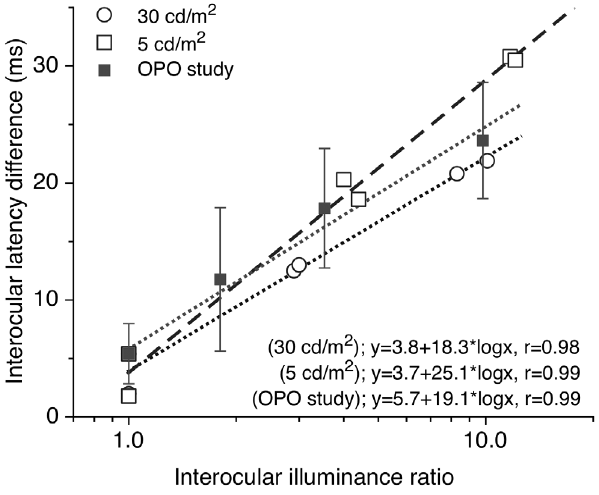
Figure 5. Interocular differences in VEP latency as a function of the interocular ratio of retinal illuminance. VEP latency is averaged for recordings between Day 0 and Day 7 and is plotted for two photopic luminance levels (30 vs. 5 cd/m 2 ). The results of an earlier study[14] using 7 subjects are shown for comparison. The bars indicate 6 1 SD.